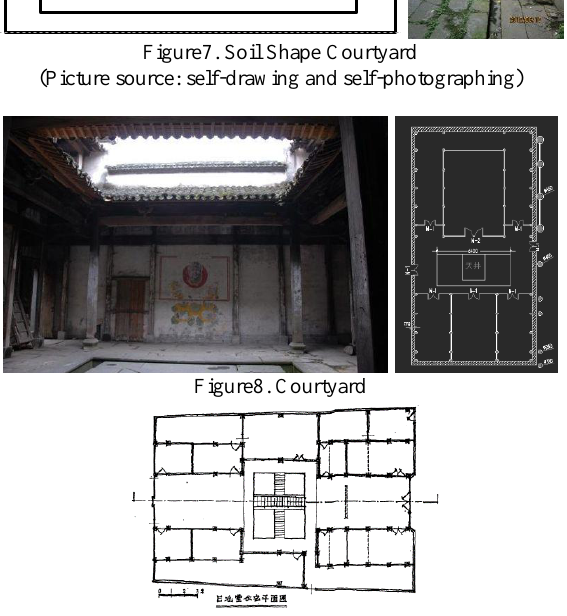
Figure8. The Plan of Ri Shape Building in Tangyin (Picture source: Shao Zengze, 1982 )